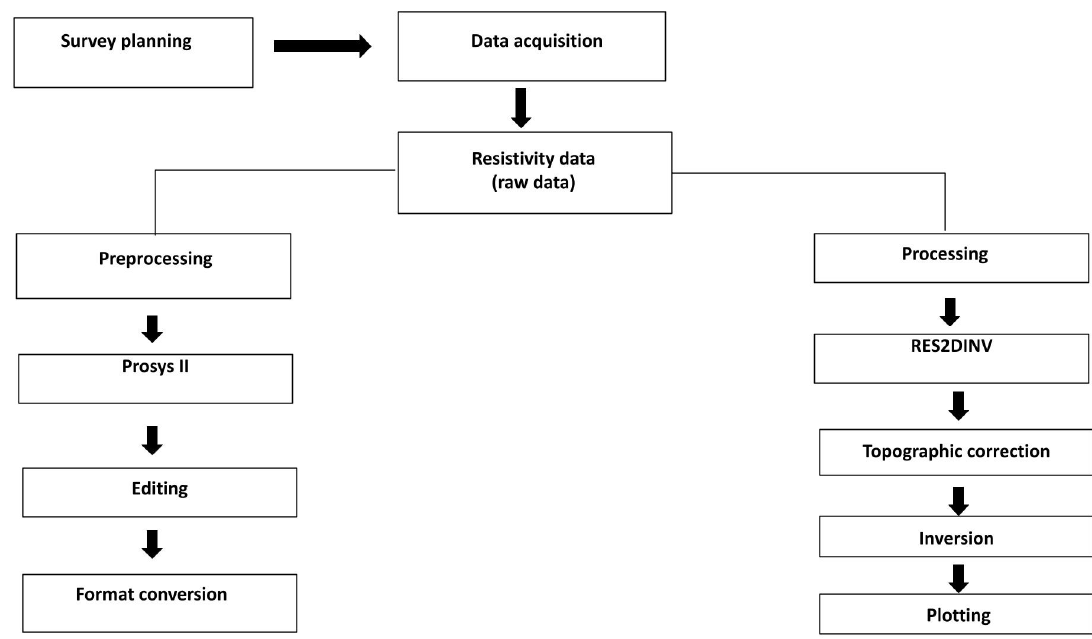
Figure 5. Processing workflow of DC resistivity data.